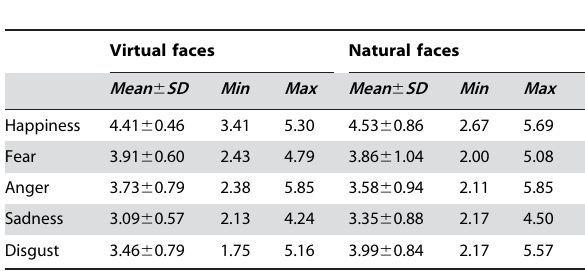
Table 5. Mean subjective intensity ratings for virtual and natural faces (on a scale from 1-not intense to 6-very